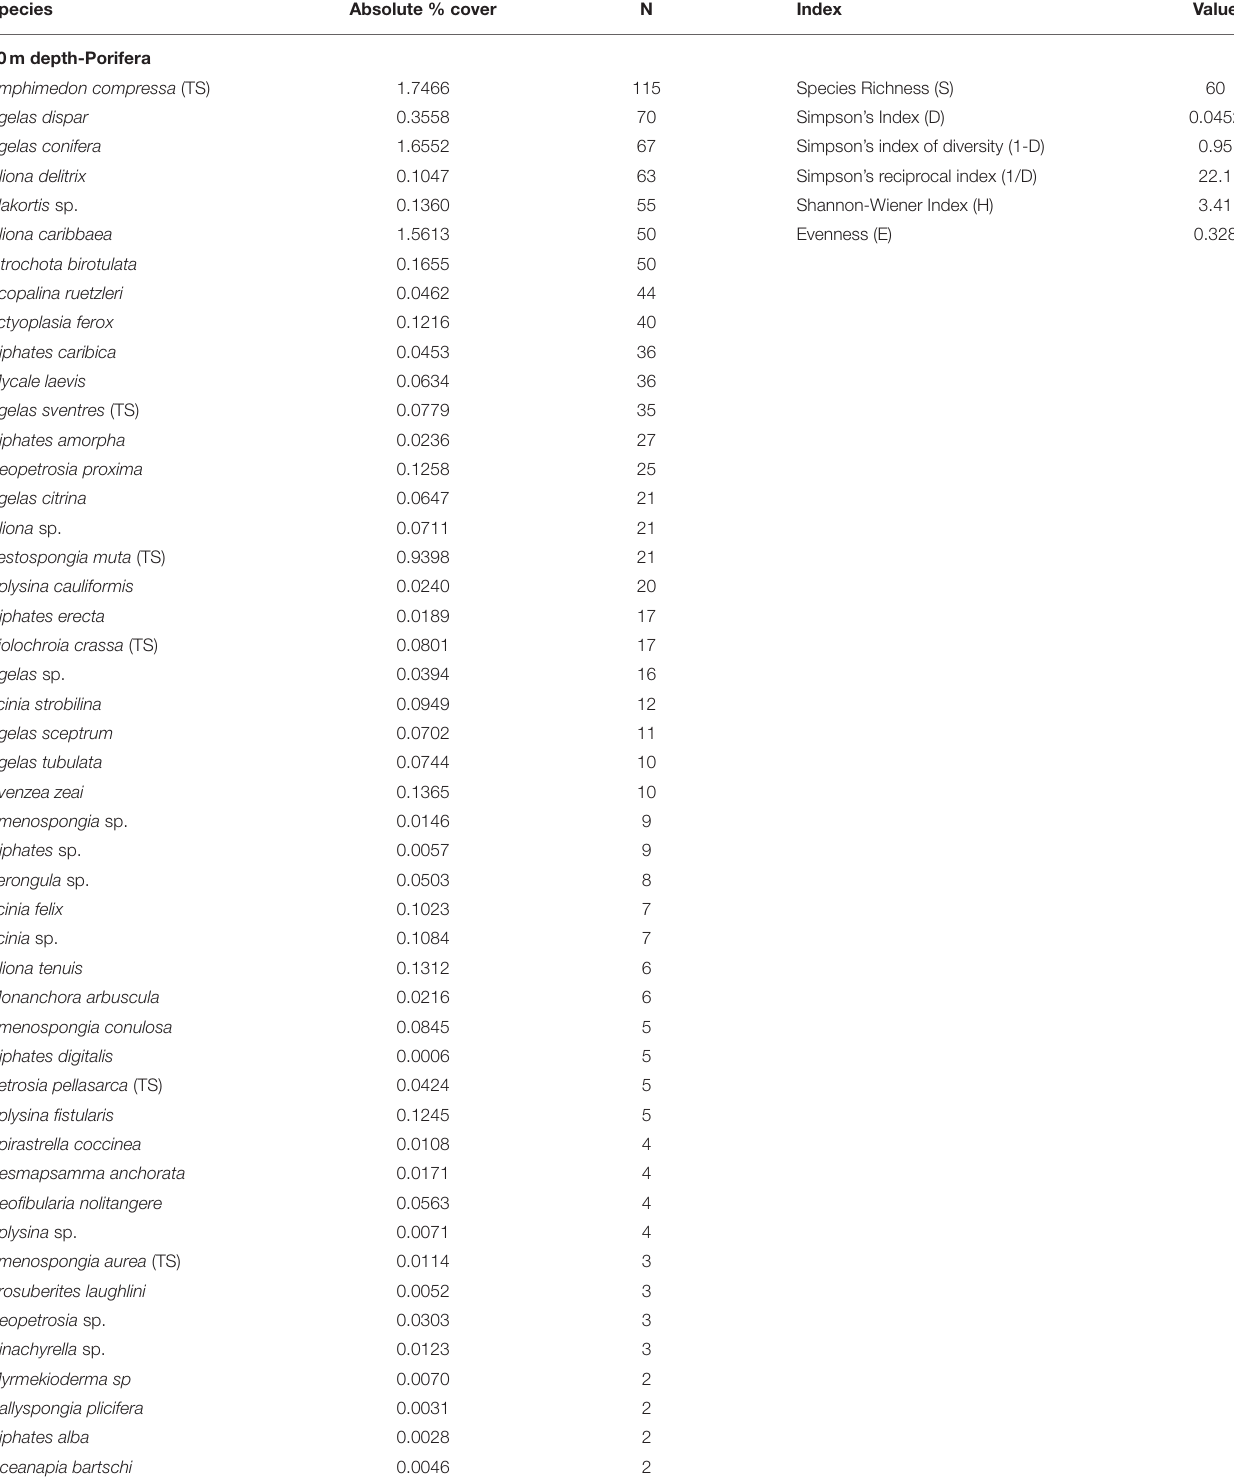
TABLE 5 | Marine species identified in altiphotic (20m) and deep (45m) transect surveys from the central portion of the Guánica shelf edge, ∼ 40 m 2 was surveyed per depth